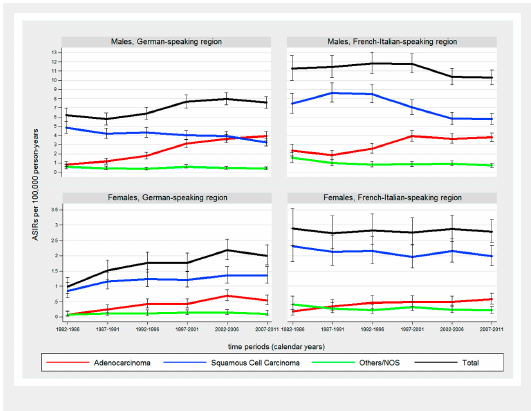
Time trends in age-standardised incidence rates (ASIRs) (European standard population) of oesophageal cancer by sex, histological subtype and language region from 1982 to 2011. NOS = not otherwise specified